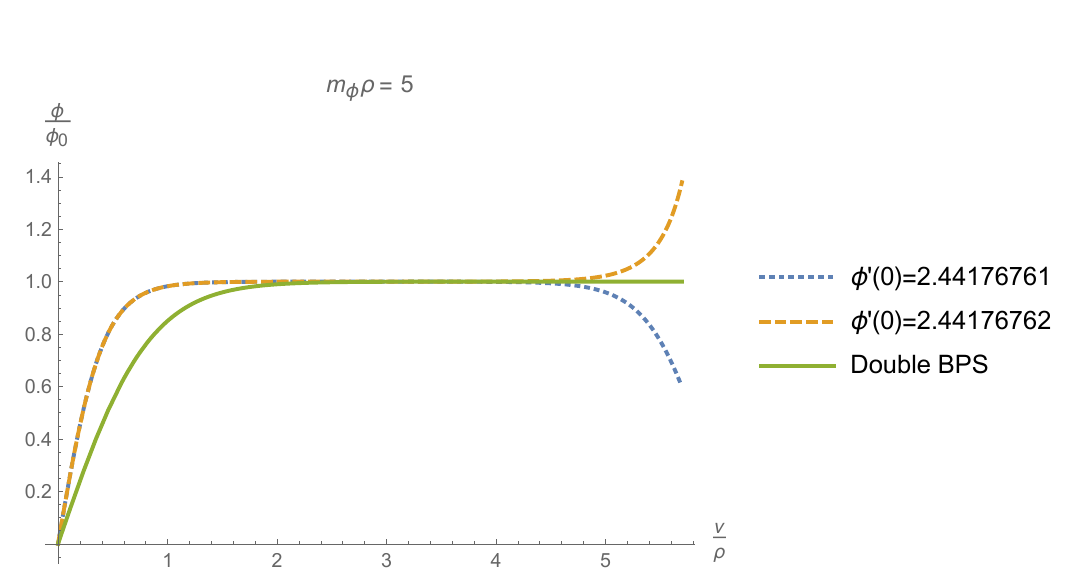
Figure 14 . Numerical solution for the Nielsen-Olesen vortex ( q; l ) = (2 ; 2) in anti de Sitter space in the m A 0 limit with the Higgs (cid:12)eld Compton wavelength 1 =m (cid:30) = (cid:26)= 5. As expected, the decay # behavior of the (cid:30) (cid:12)eld is dominated by the Compton wavelength. As a comparison, the curve in green is the exact double BPS solution where the Higgs (cid:12)eld has in(cid:12)nite Compton wavelength and the length scale is set by the radius of curvature (cid:26) . The shooting method is very sensitive to the initial condition (cid:30) 0 (0) due to the potential presence of exponential growth terms; compare the dotted blue curve with the dashed orange curve. Numerical methods become more (cid:12)nicky as m (cid:30) (cid:26) increases.